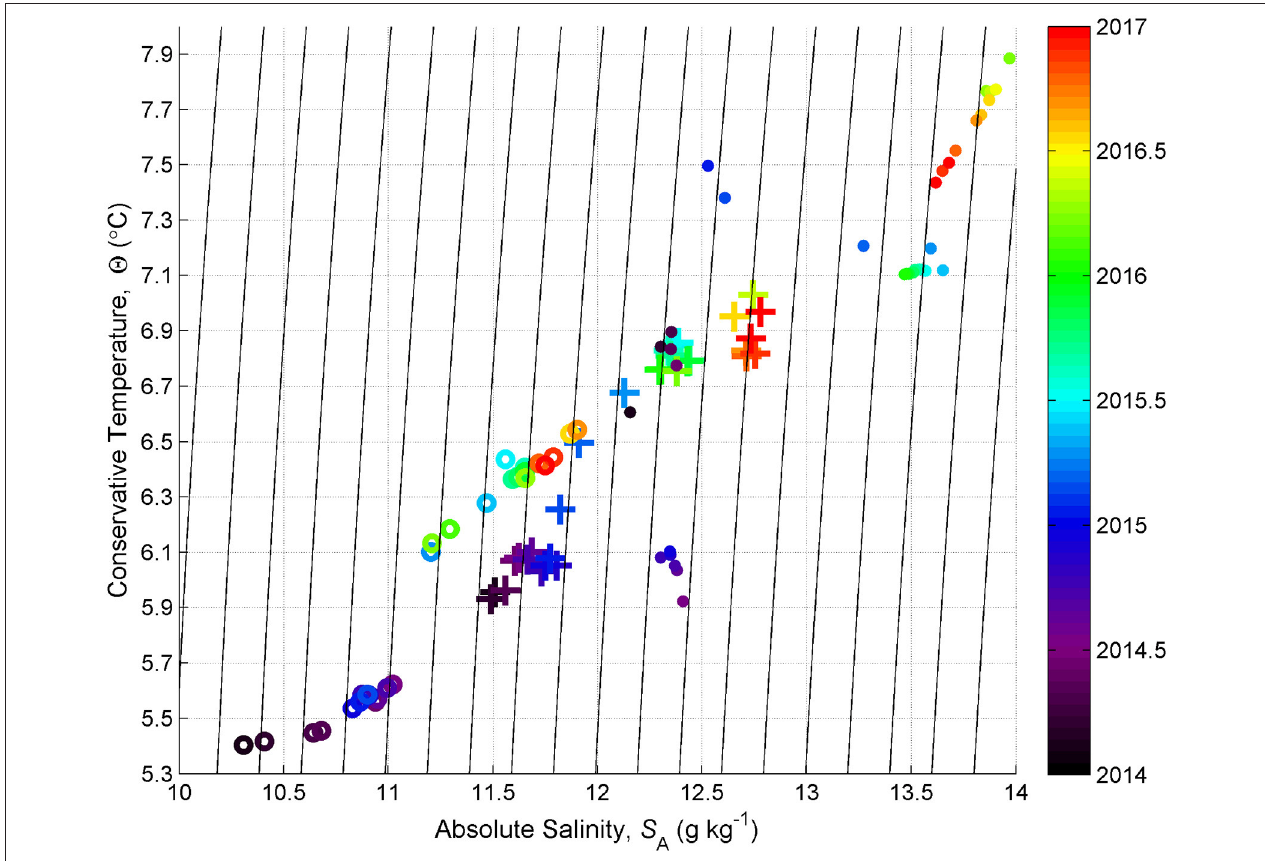
FIGURE 8 | Temporal development of near-bottom temperature-salinity in the Gotland Deep (filled circles), Fårö Deep (crosses), and Northern Deep (circles). Color scale represents time (years).